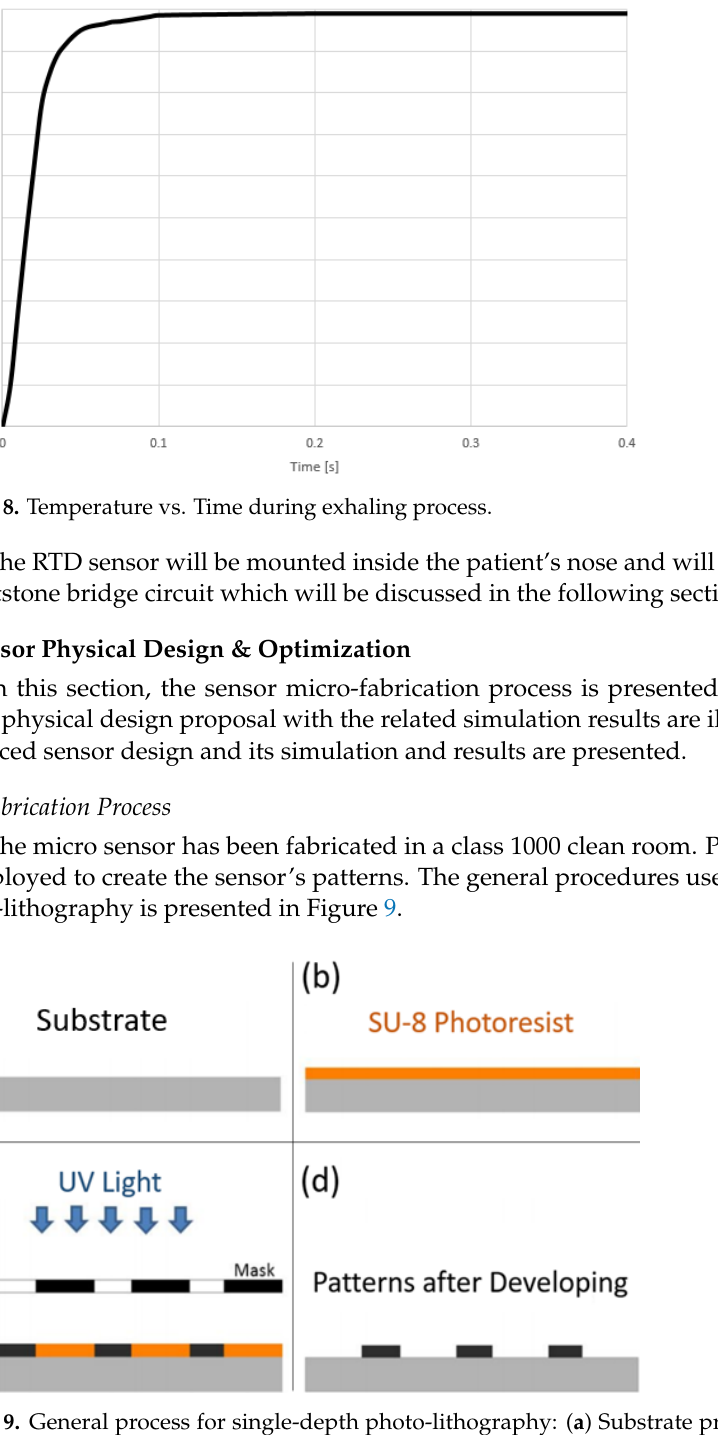
Figure 9. General process for single-depth photo-lithography: ( a ) Substrate preparation; ( b ) Spin coating; ( c ) UV exposure; ( d )